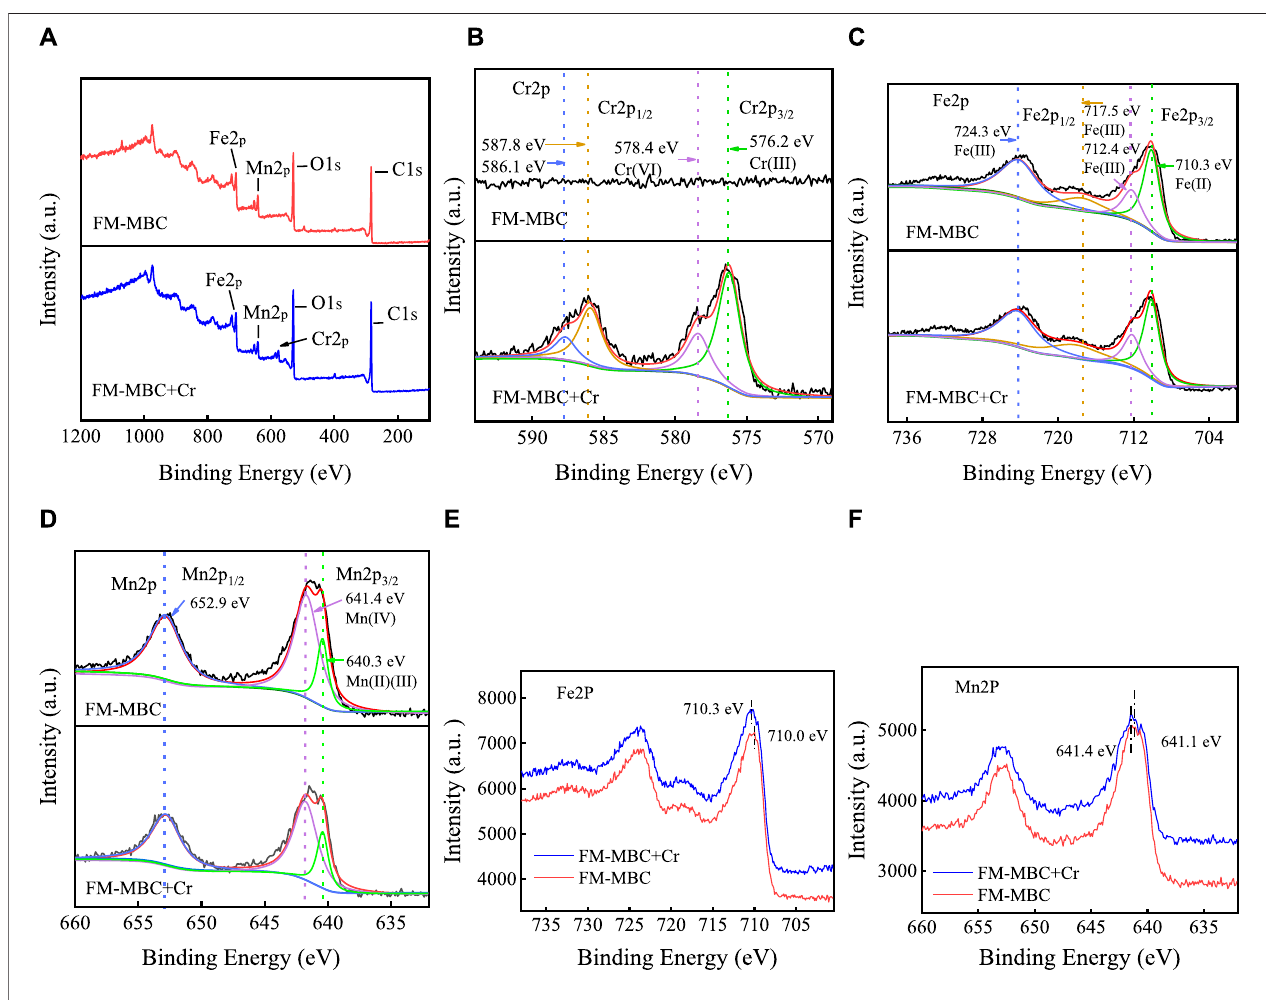
FIGURE 8 | XPS spectra for MBC-MFC and MBC-MFC + Cr. (A) survey; (B) Cr2p; (C, E) Fe2p; (D, F) Mn2p.